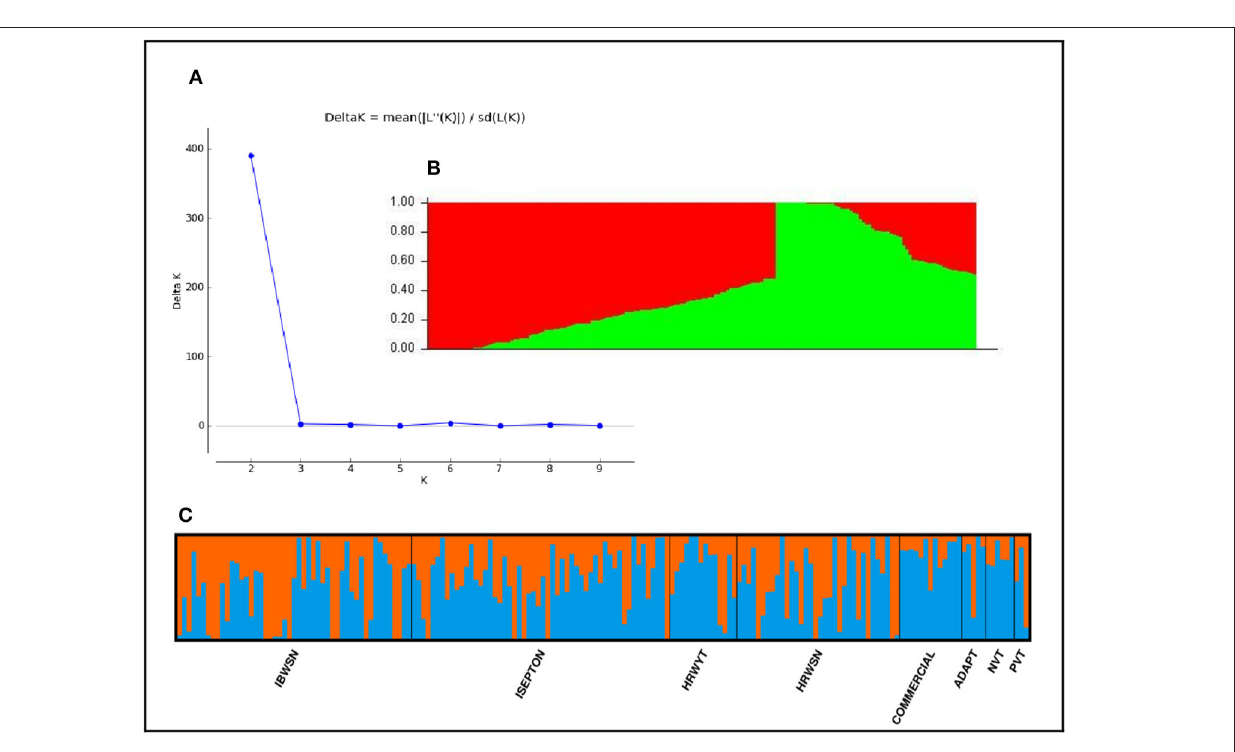
FIGURE 2 | Population structure of the 178 bread wheat genotypes representing eight populations. (A) Best delta K value estimated using the method of Evanno et al. (2005), and the pick at k = 2 indicates the number of subpopulations in our collection, (B) Population structure plot and SP1 and SP2 represents subpopulations 1 and 2, respectively, (C) Estimated population structure for K = 2 according to the breeding materials. The different (blue and orange) co lures represent genetic groups or sub-populations designated by Structure Harvester: the x-axis represents individual samples and y-axis represents the proportion of ancestry to each cluster. Population abbreviations are: IBWSN, International Bread Wheat Screening Nursery; ISEPTON, International Septoria Observation Nursery; HRWYT, High Rain Wheat Yield Trial; HRWSN, High Rain Wheat Screening Nursery; ADAPT, Adaptation t1ial; NVT, National Verification Trial, and PVT, Preliminary